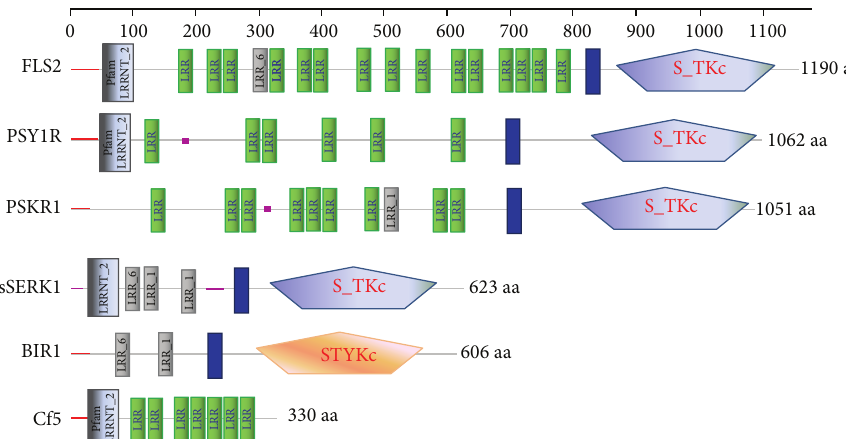
Figure 2: Schematic diagram of the protein features of the identified LRR-RLKs. This diagram was constructed using the predicted amino acid (aa) sequences from retrieved proteins and SMART online program. The size of each protein is presented with a grey line. The predicted domains are highlighted in each protein. The signal peptides are shown as red boxes, while the low complexity regions and transmembrane regions are shown as pink boxes and blue boxes, respectively. LRRNT 2: leucine rich repeats domains that consist of 2–45 motifs of 20–30 amino acids in length that generally fold into a horseshoe shape. LRR: leucine rich repeat domain; S TKc: serine/threonine protein kinases, catalytic domain; STYKc: dual-specificity serine/threonine/tyrosine kinase